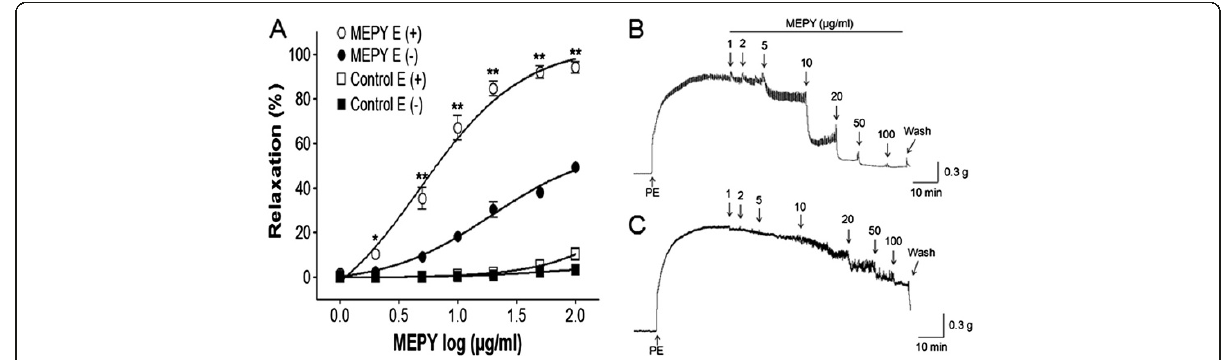
Figure 1 Concentration-dependent relaxant effects of MEPY on phenylephrine (PE, 1 μ M)-pre-contracted rat aortic rings with [(E+)] or without [(E-)] endothelium (A) in Krebs-Henseleit solution. Control groups were not treated with MEPY. The MEPY induced-relaxant traces of aortic rings with [(E+)] (B) or without [(E-)] endothelium (C) . The relaxant effects of MEPY on isolated rat aortic rings were calculated as a percentage of the contraction in response to PE. Values are expressed as mean ± SEM (n = 8). * P < 0.05, ** P < 0.01 vs . MEPY E ( −